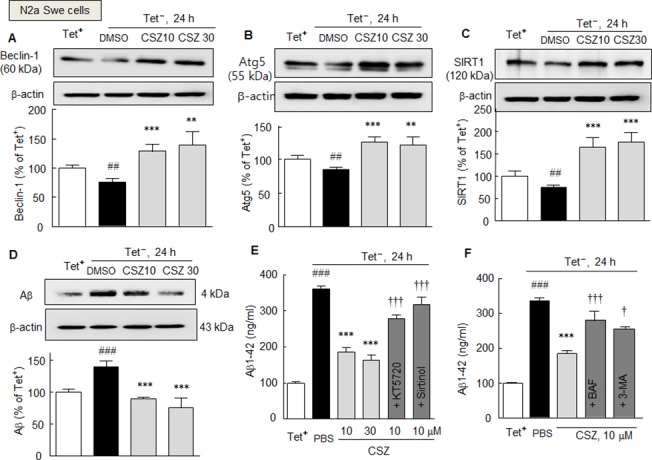
A—C. Inhibition of Tet- condition-induced reductions in beclin-1 (A), Atg5 (B) and SIRT1 expressions (C) by cilostazol (10 or 30 μM) in N2aSwe cells. D. Inhibition of Tet- condition-induced endogenous increases in Aβ level by cilostazol as determined by Western blotting (D) and of intracellular Aβ accumulation as determined by ELISA (E, F). The inhibitory effects of cilostazol were blocked by KT5720 (1 μM), sirtinol (20 μM) (E), bafilomycin A1 (BAF, 100 ng/ml), or 3-methyladenine (3-MA, 2.5 mM) (F).Results are presented as means ± SDs (N = 4–5). ##
P < 0.01, ###
P < 0.001 vs. Tet+ condition (as control), **P < 0.01 ***P < 0.001 vs. DMSO; †
P < 0.05, †††
P < 0.001 vs. cilostazol alone (CSZ, 10 μM). PBS, phosphate-buffered saline.